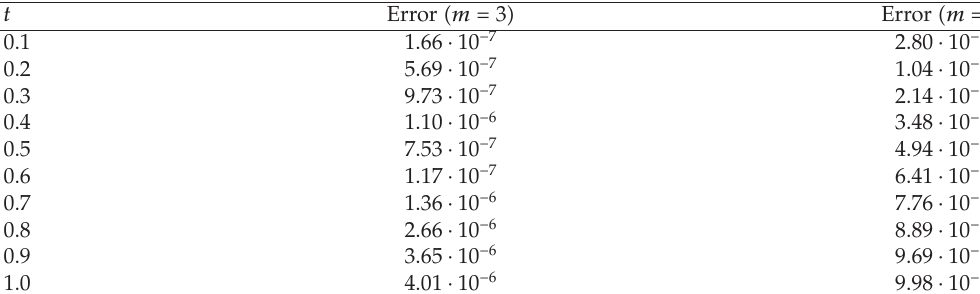
Table 4: Problem (cid:4) 5.5 (cid:5) —Example 5.4.